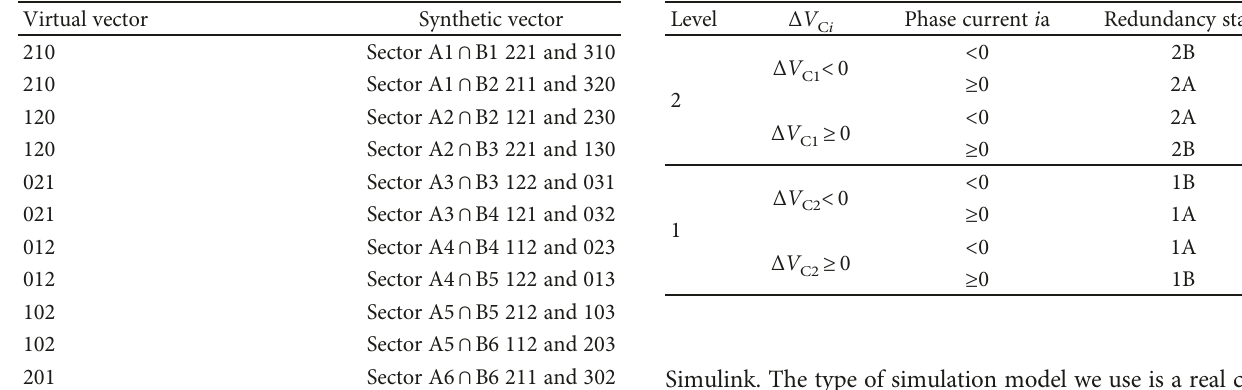
Table 4: Relationship between virtual and synthesis vectors. Table 5: Mechanism of capacitor voltage